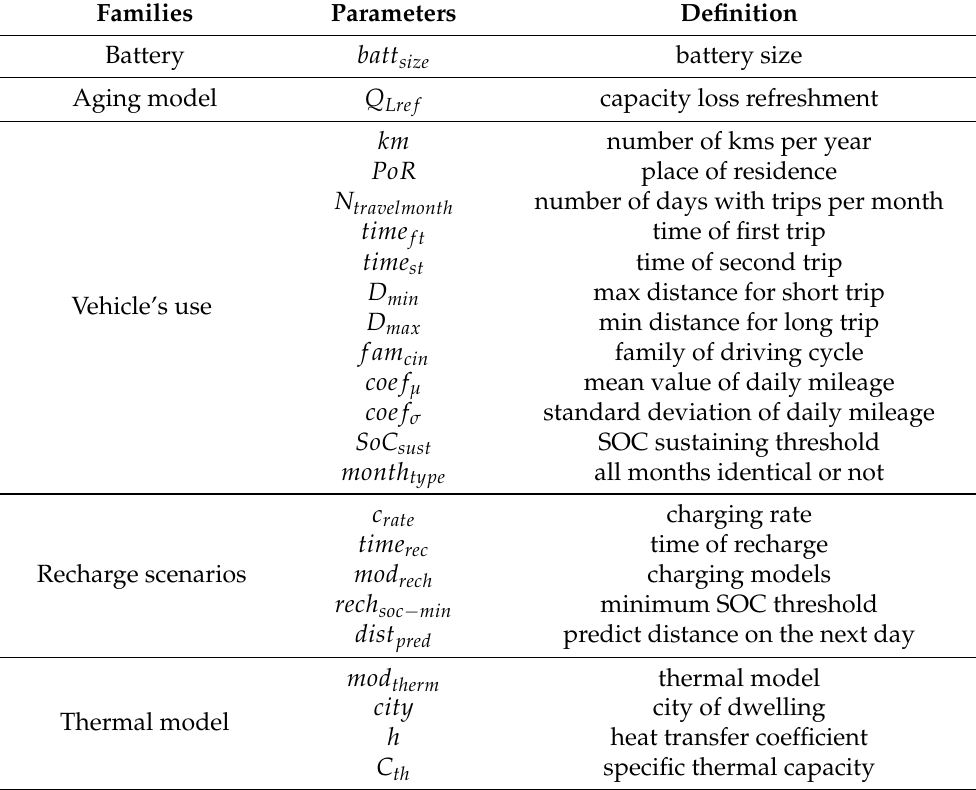
Table 2. Parameters of the sensitivity